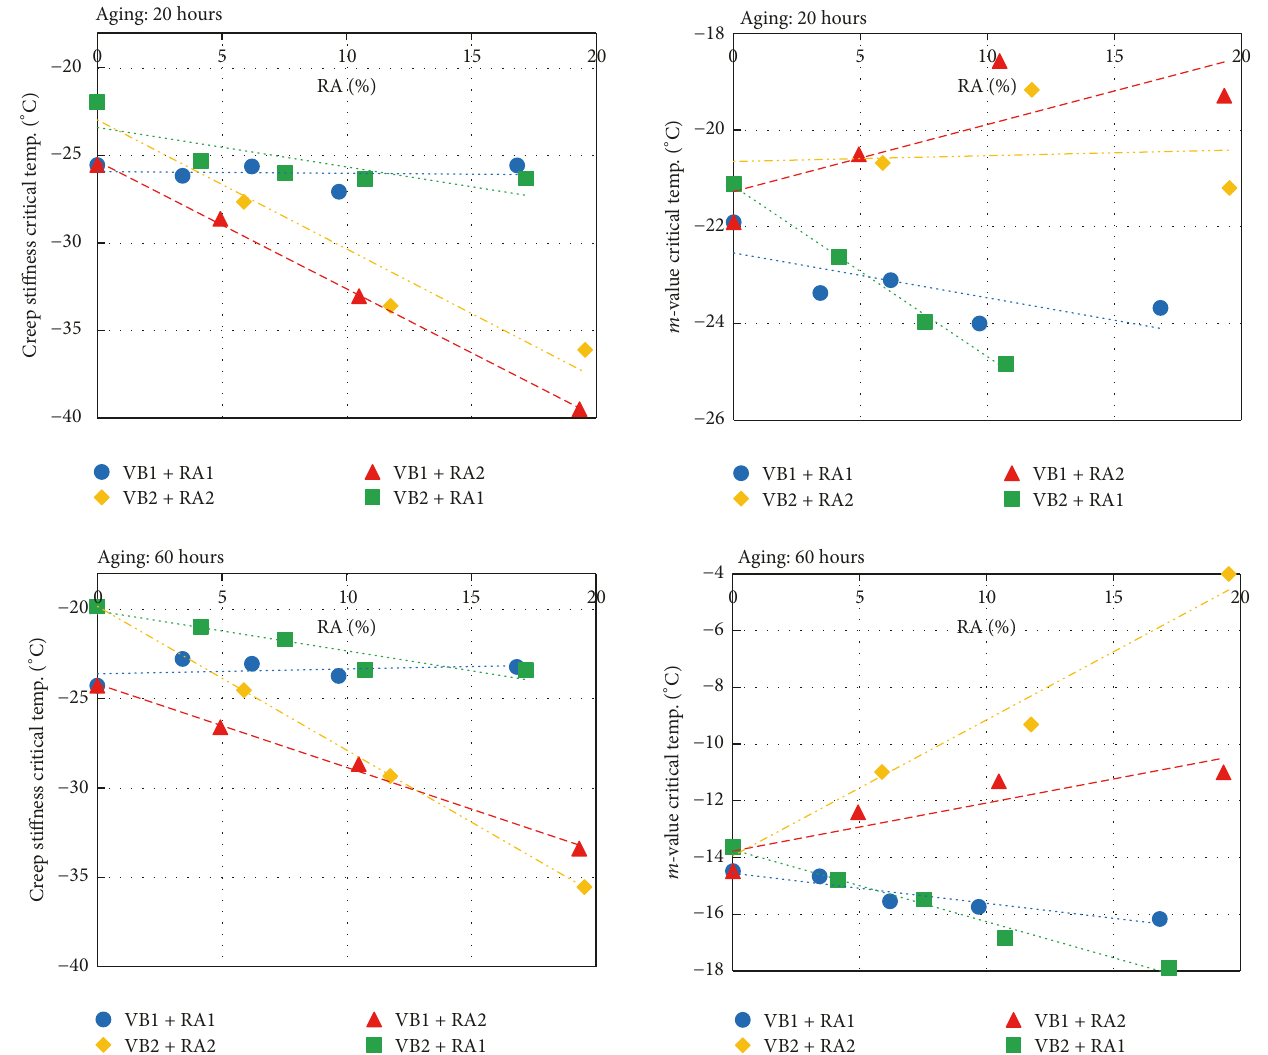
Figure 8: Variations of creep stiffness and 𝑚 -value critical temperatures with the rejuvenator